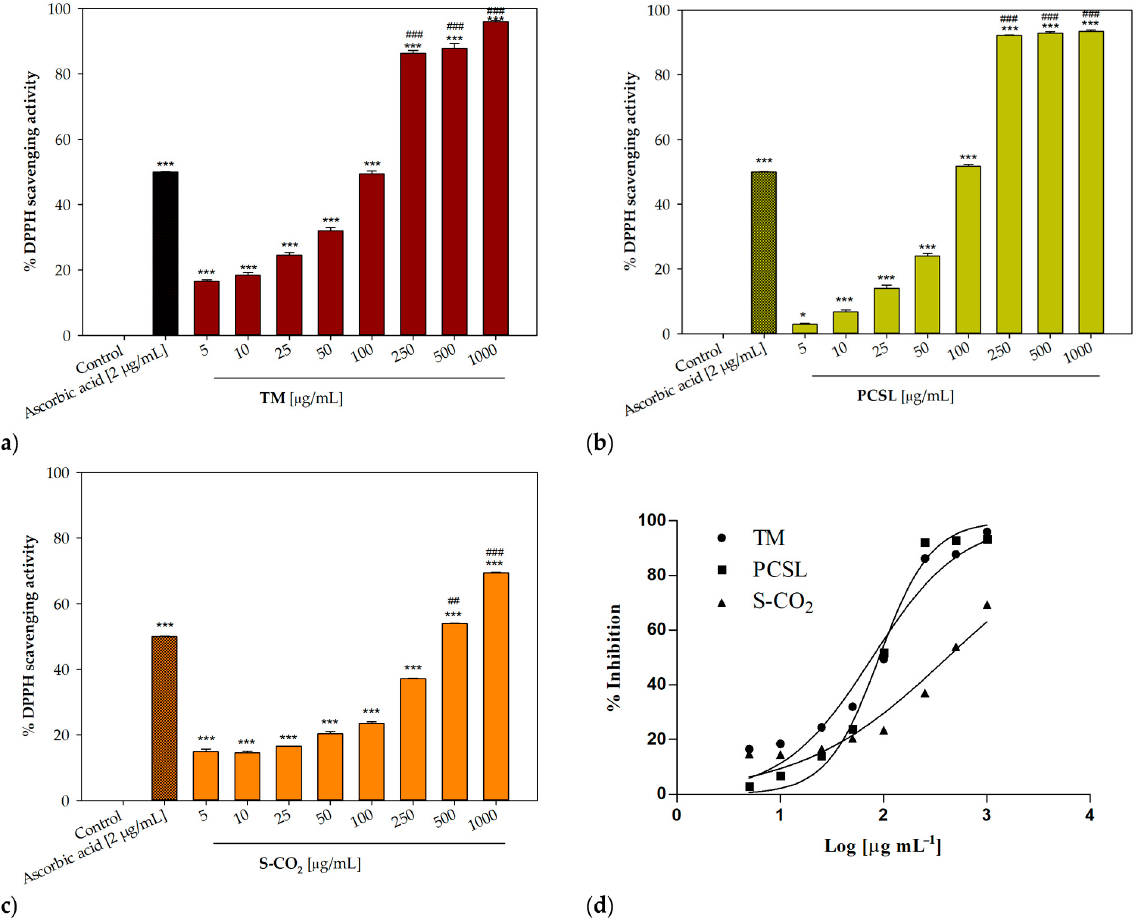
Figure 3. Concentration-dependent radical scavenging activity of P. ferulacea Lindl. extracts. ( a ) Traditional maceration, TM; ( b ) pressurized cyclic solid–liquid extraction, PCSL; ( c ) supercritical CO 2 extraction, S-CO 2 ; ( d ) nonlinear regression analyses; * p < 0.05, *** p < 0.001 compared to control (Dunnett’s test); ## p < 0.01 ### p < 0.001 compared to positive control (ascorbic acid, 2 μ g/mL).